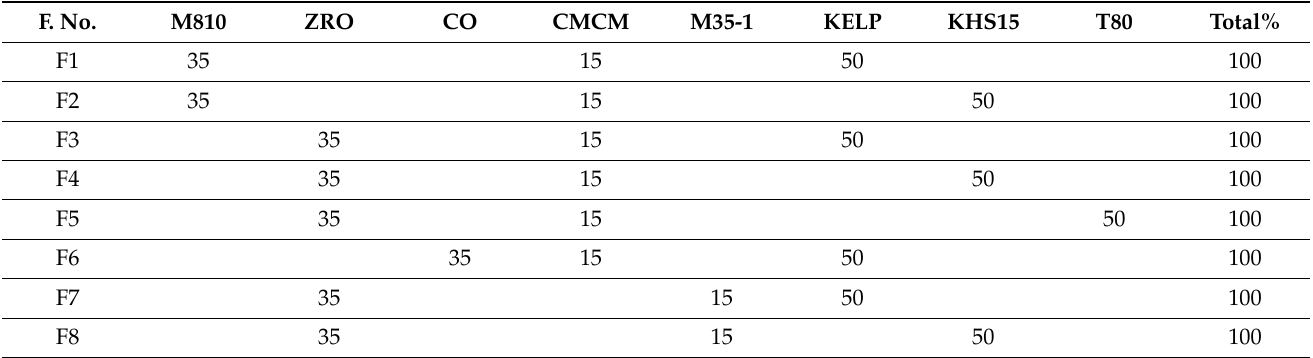
Table 1. The composition of the formulations developed for propofol. The systems show the composition of excipients used in each formulation at different ratios (% w / w